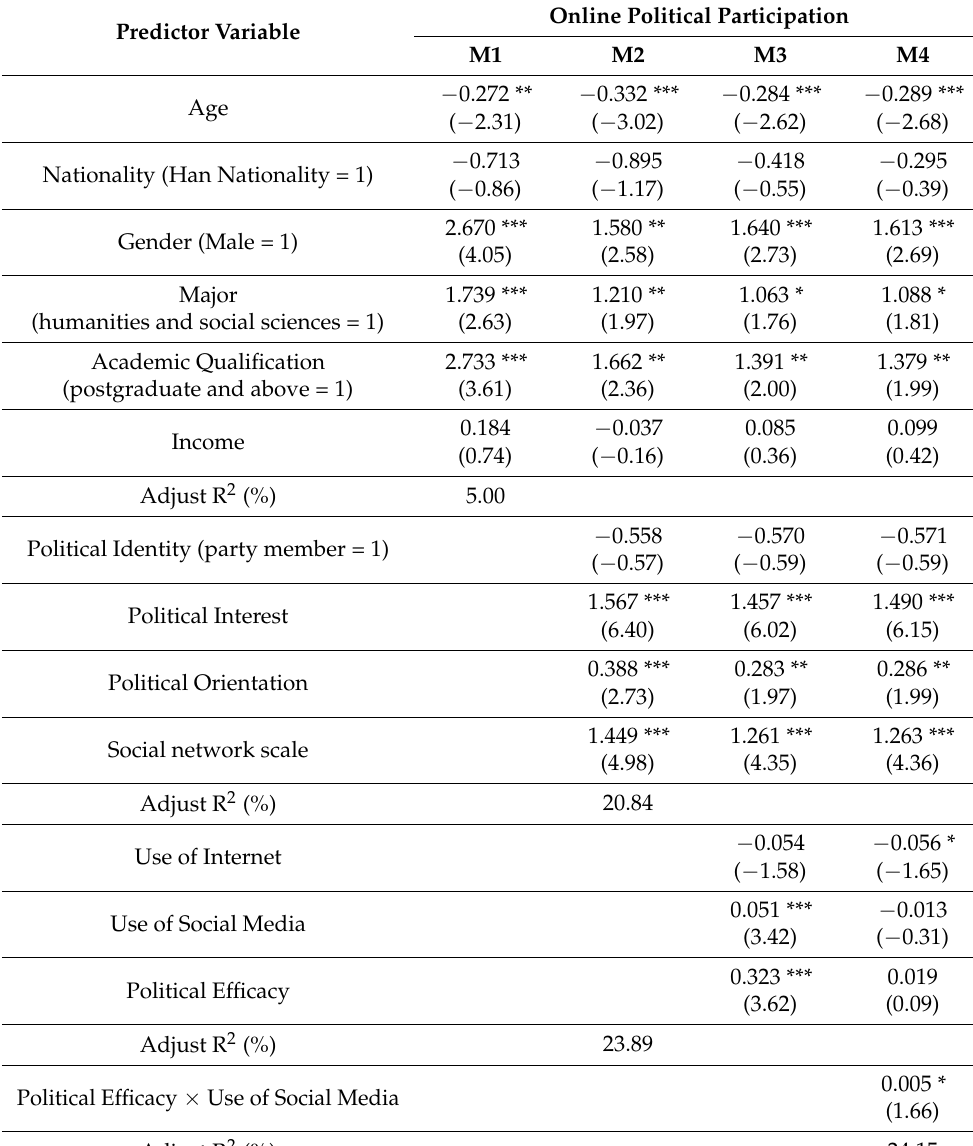
Table 2. Regression analysis table of the influence of social media use on online political participation of university students in Western